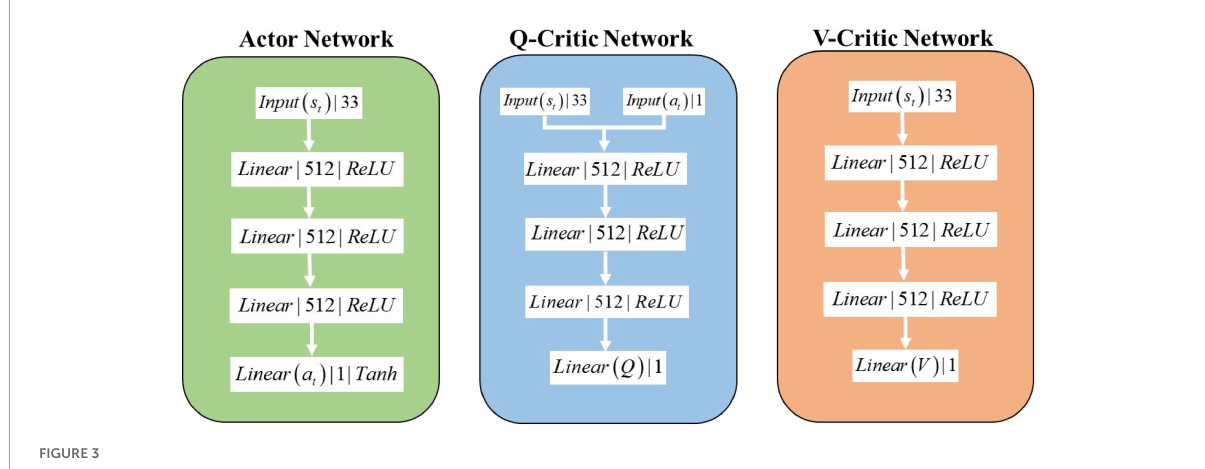
FIGURE3 SAC algorithm network